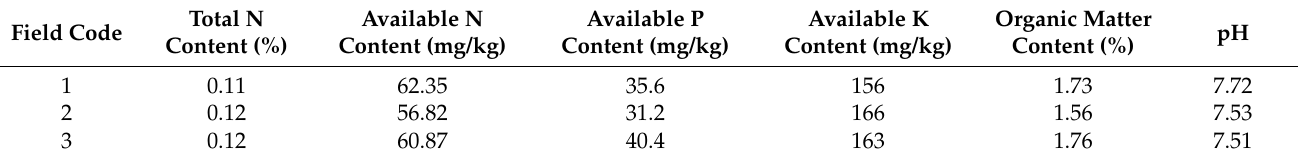
Table 2. The results of the soil testing of 12 different field